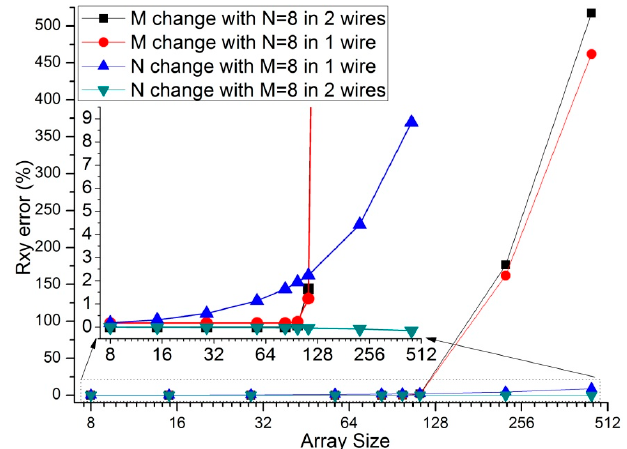
Figure 3. Array size effect on the R xy errors in the one-wire VF-NSDE circuit and the two-wire VF-NSDE circuit where R 0 = 2 Ω and R other = 10 k Ω .